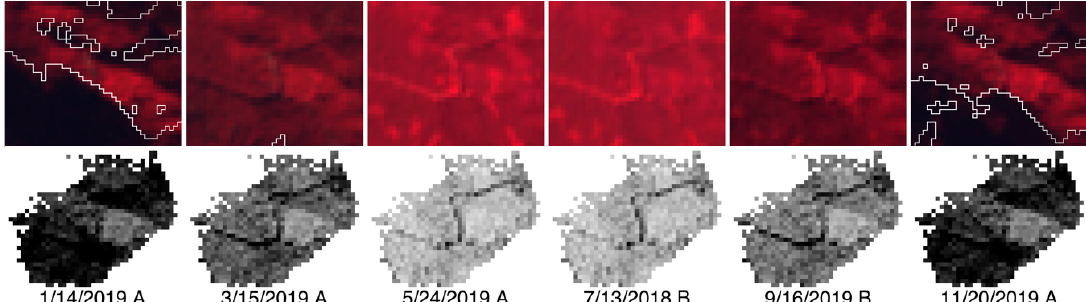
Figure 6. Example of a false color image from Sentinel-2 data ( top ) and the sunlit fraction ( bottom ). Bands 3, 4, and 8 are used for blue, green, and red, respectively. Observed reflectance from 0.0 to 0.4 is scaled into the digital image from 0 to 250. The white frame in the Sentinel-2 image shows the shadow areas calculated using a 10-m resolution digital elevation model; these areas were excluded in this analysis. “A/B” after the observation date indicates satellite A or B of Sentinel-2.